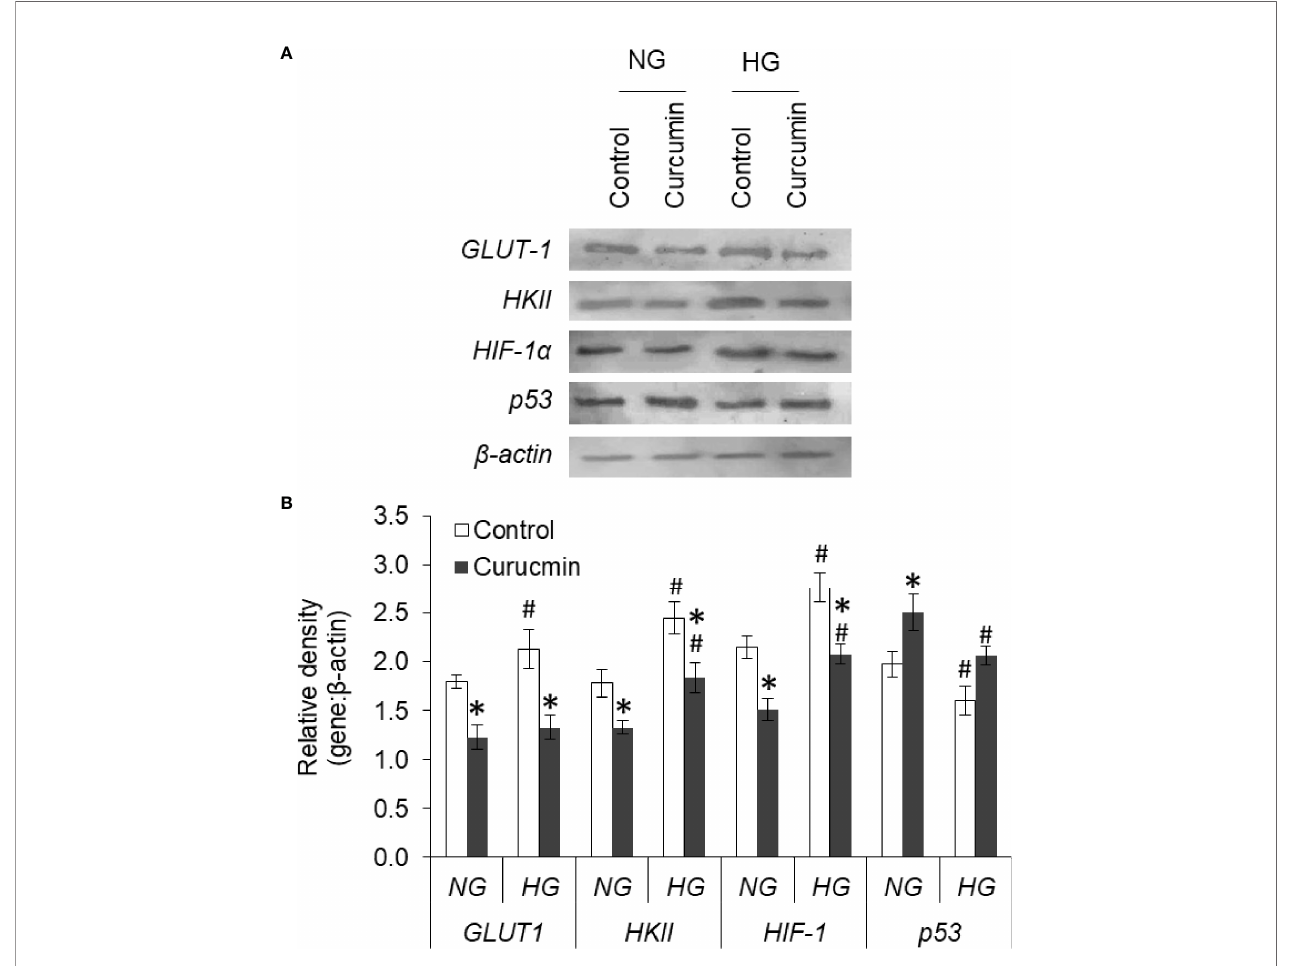
FIGURE 13 | Curcumin modulates the protein expression of GLUT-1, HKII, HIF-1 a , and p53. HepG2 cells were incubated in NG or HG medium with and without curcumin and GLUT-1, HKII, HIF-1 a , and p53 expression was detected by western blot analysis (A) . Densitometric scan of bands were done, and relative intensity of bands against b -actin was calculated (B) . Bands shown are representative of three experiments conducted independently. The values shown are Mean ± SD of three independent experiments conducted in triplicate. * p < 0.05 vs values of cells of control group. # p < 0.05 values of cells incubated in NG